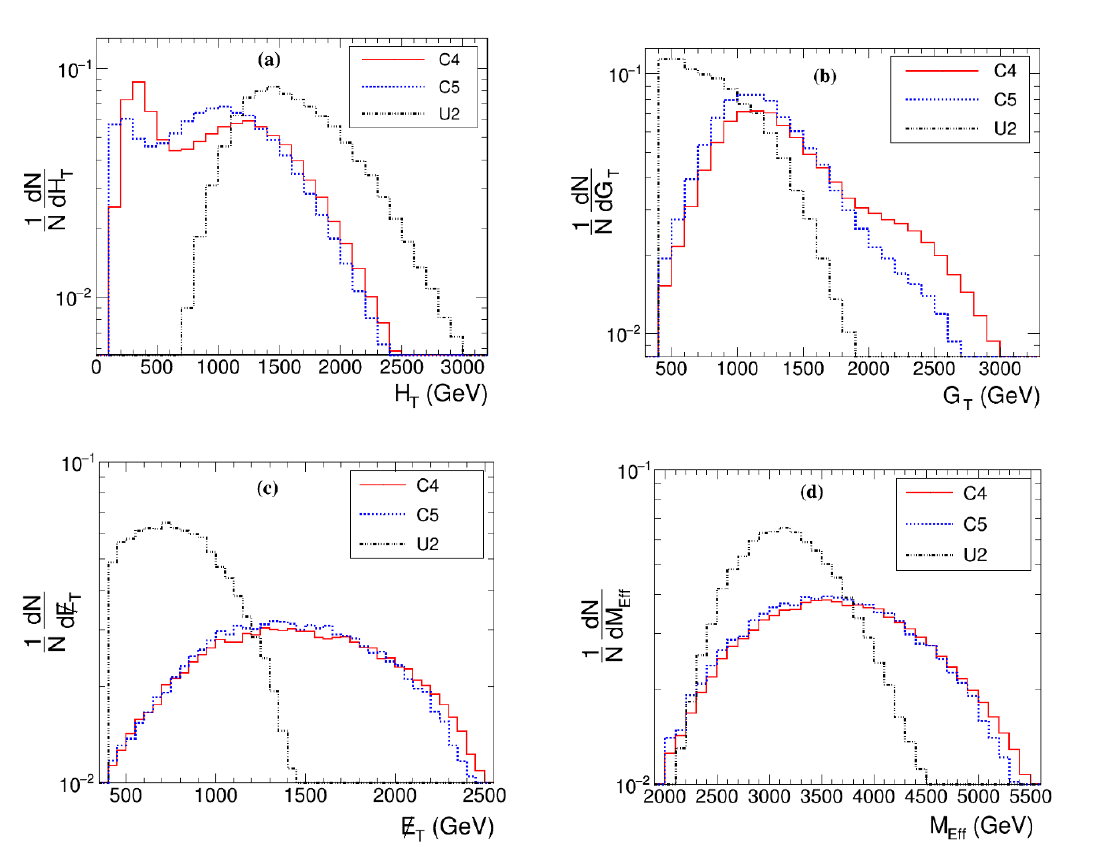
Figure 6 . Normalized distributions of total hadronic energy deposit H T ,total photon energy deposit G T , missing transverse energy E= T and E(cid:11)ective Mass M Eff , for benchmark points representing var- ious compressed ( C4 ), more compressed ( C5 ) and uncompressed ( U2 ) spectra after implementing the selection and analysis cuts A0 { A6